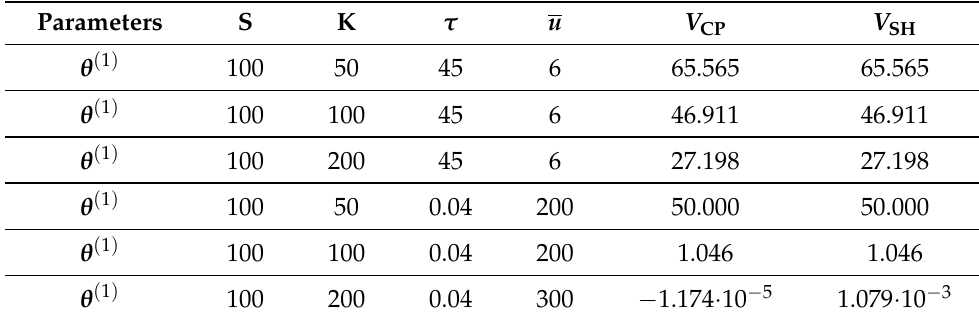
Table 3. Results for different u and/or using the ChF from